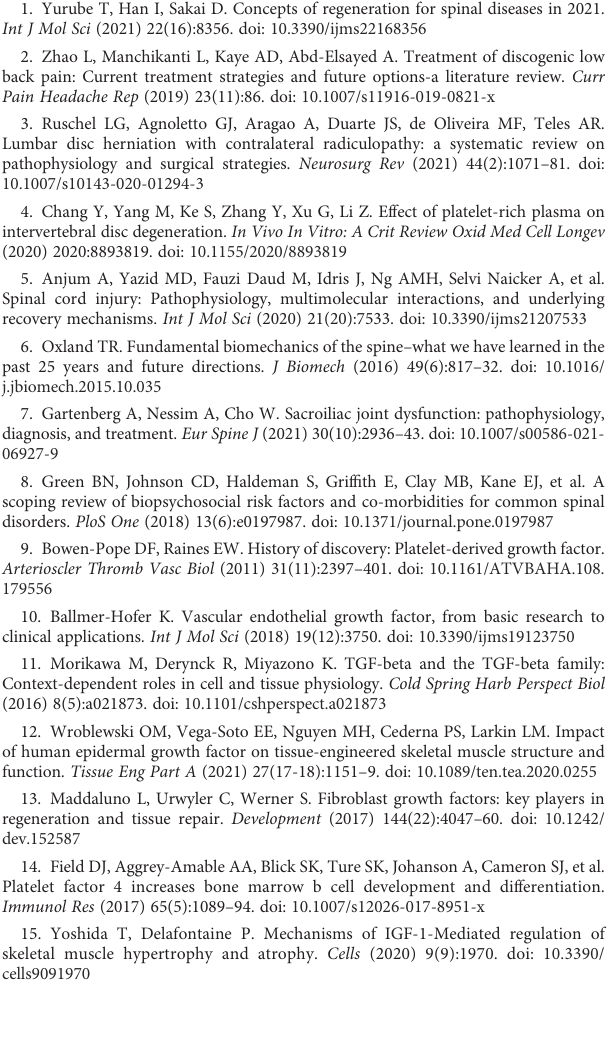
Table 1 HW, JZ, YX, and YL revised the